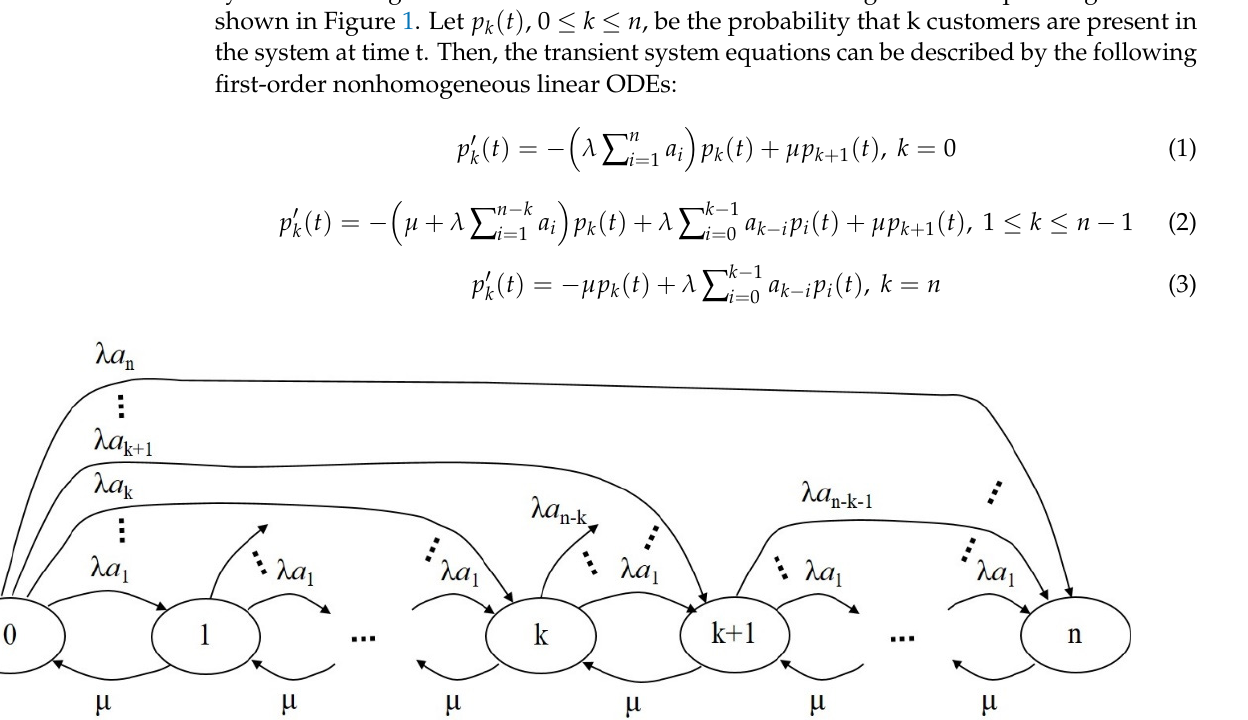
Figure 1. The single server queueing model with finite capacity and bulk arrivals.